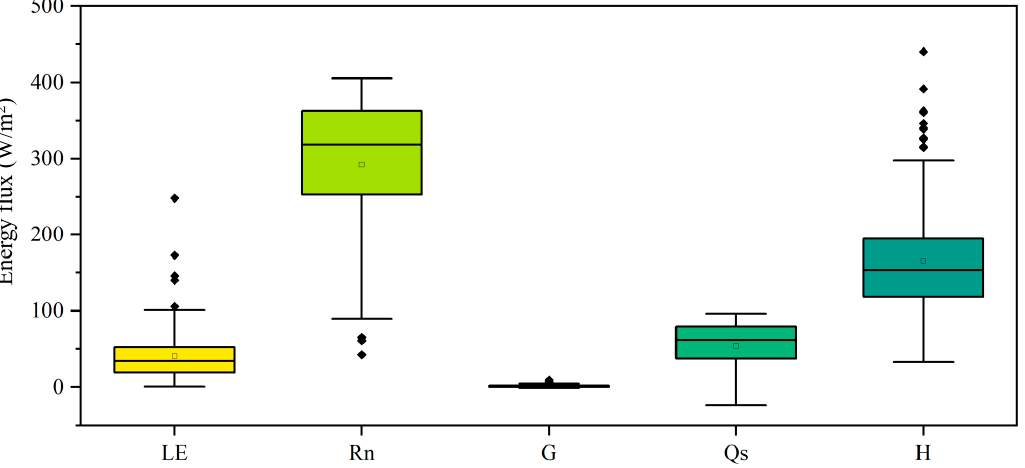
Figure 6. Boxplots showing the footprint-weighted values of each urban energy balance component at the scale of the footprint during the study period. The hollow and solid dots represent the average and abnormal values of the variables, respectively.